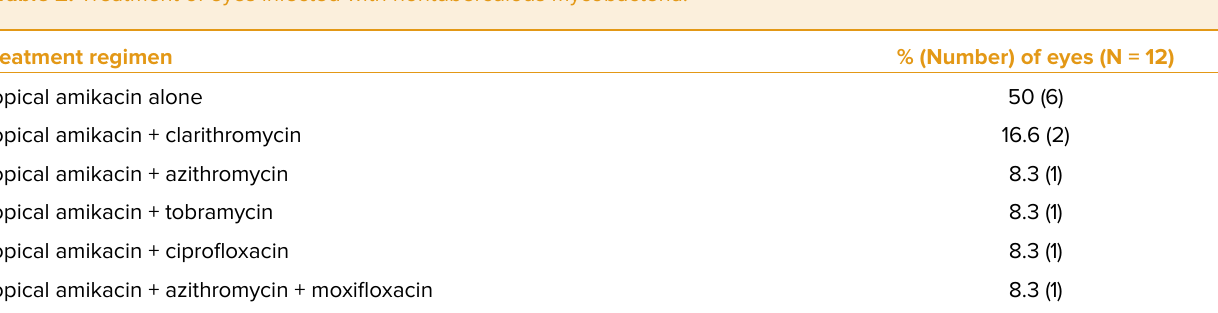
Table 2. Treatment of eyes infected with nontuberculous mycobacteria. Treatment